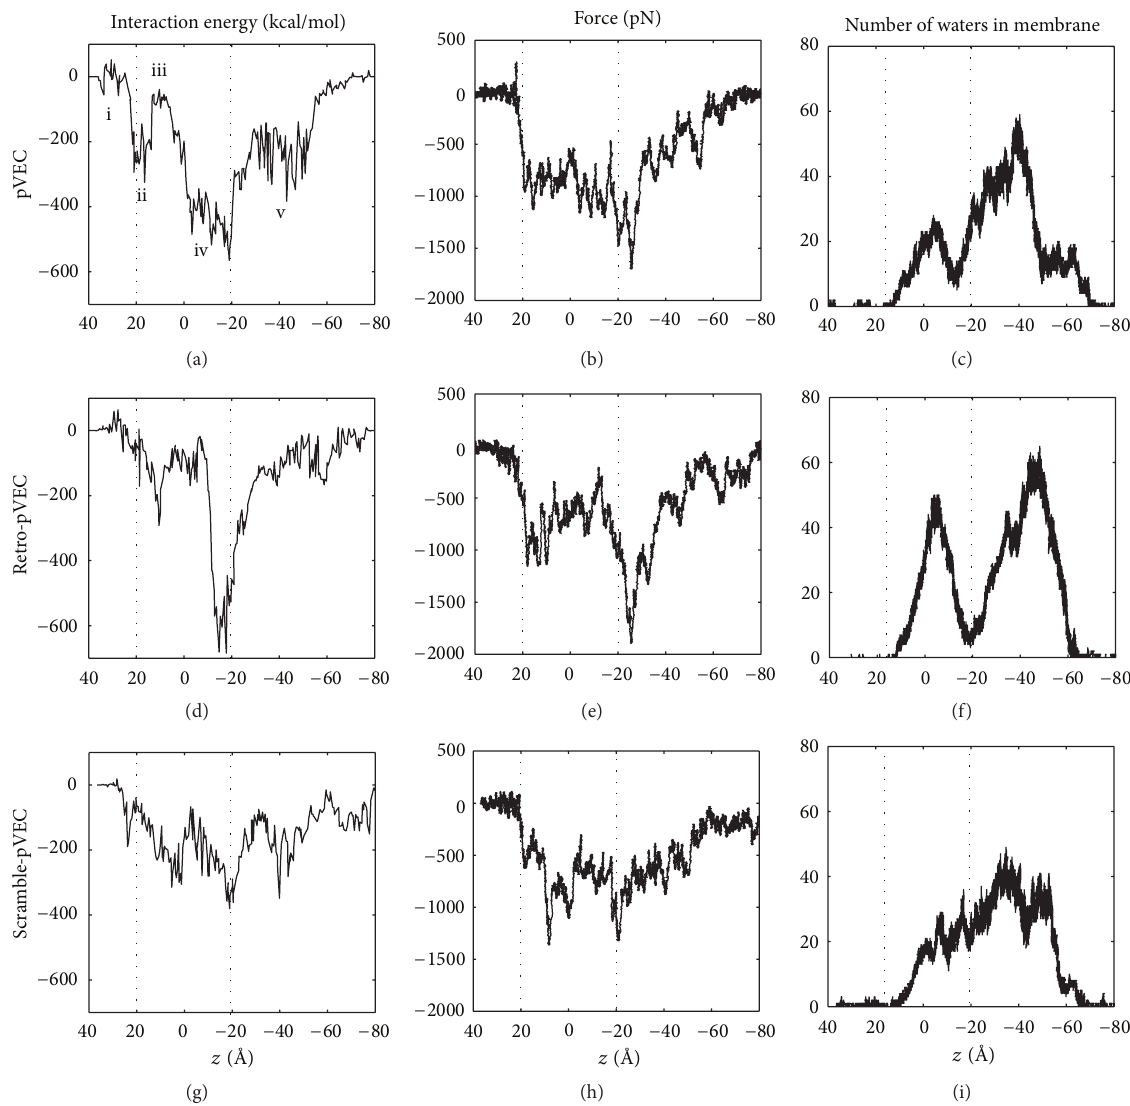
Figure 2: Interaction energy between the lipid and peptide atoms (left panel), force applied to the SMD atom (middle panel), and the number of water molecules in the membrane boundary (right panel) is shown as a function of the SMD atom z -coordinate for SMD simulations on the pVEC (top), retro-pVEC (middle), and scramble-pVEC (bottom) transport across the lipid bilayer. The membrane boundaries are indicated by the dashed lines at 𝑧 = 20 ˚A and − 20 ˚A. The regions in which the interaction energy between wild type pVEC and the membrane stays constant for more than 5ns are indicated in panel